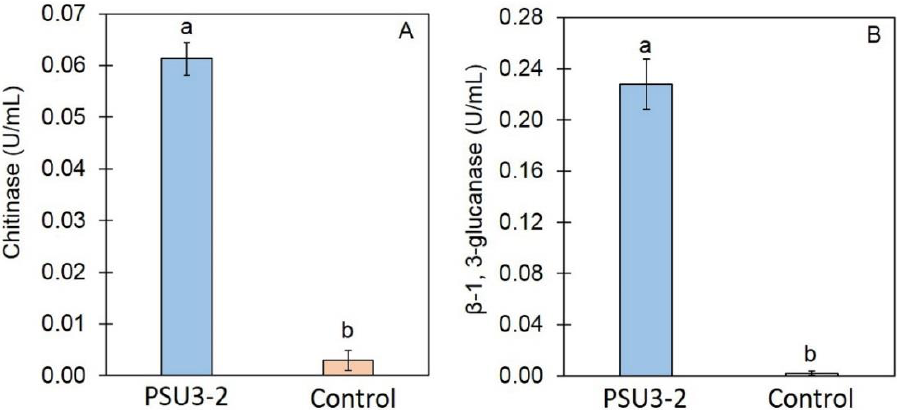
Figure 3. Cell-wall-degrading enzyme activities of cell-free culture filtrate (CF) of T. koningiopsis PSU3-2: ( A ) enzyme activity of β -1,3-glucanase; ( B ) enzyme activity of chitinase. Different letters indicate statistically significant differences among treatments ( p < 0.05) using Tukey’s test.